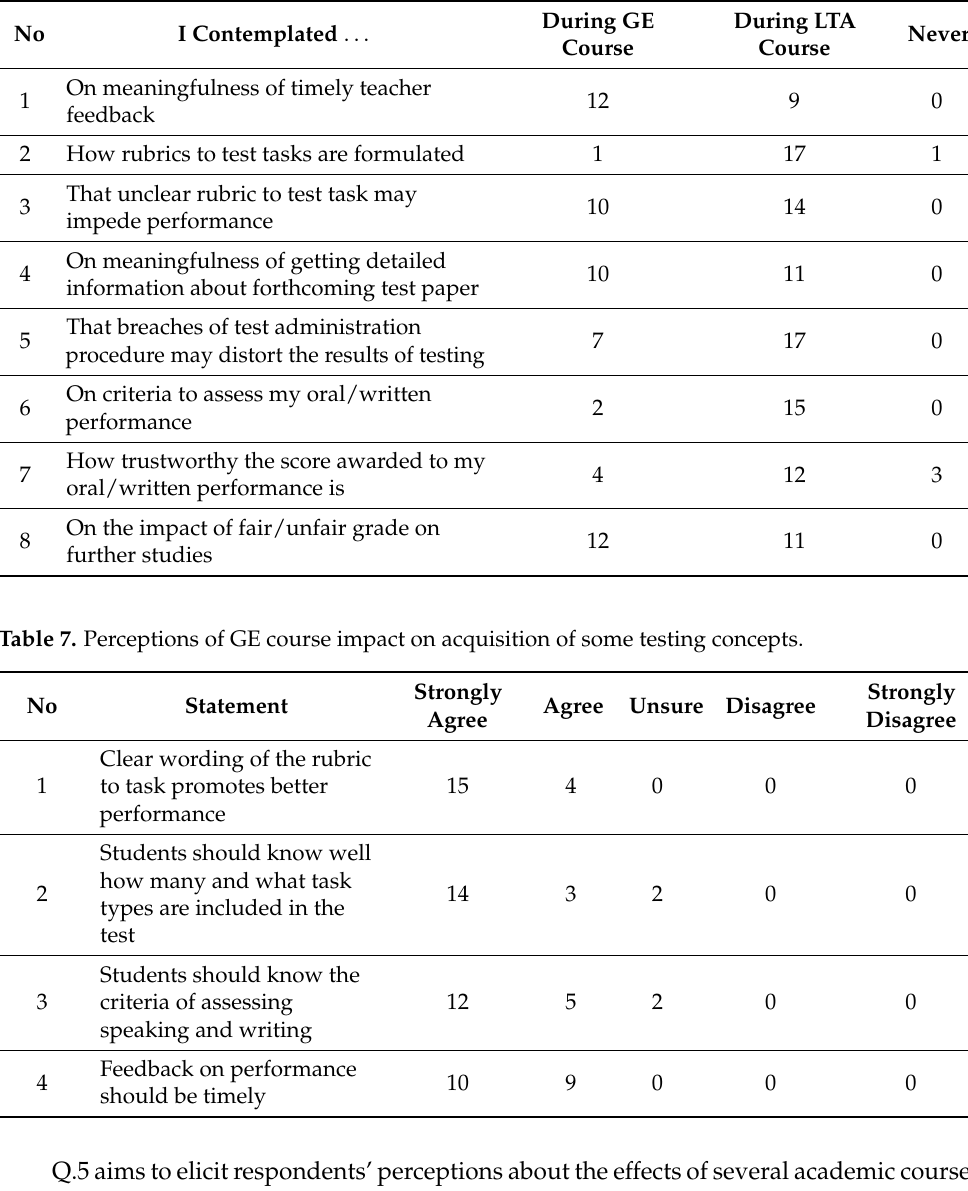
Table 6. Perceived points in time when initial reflections on LTA concepts occurred.